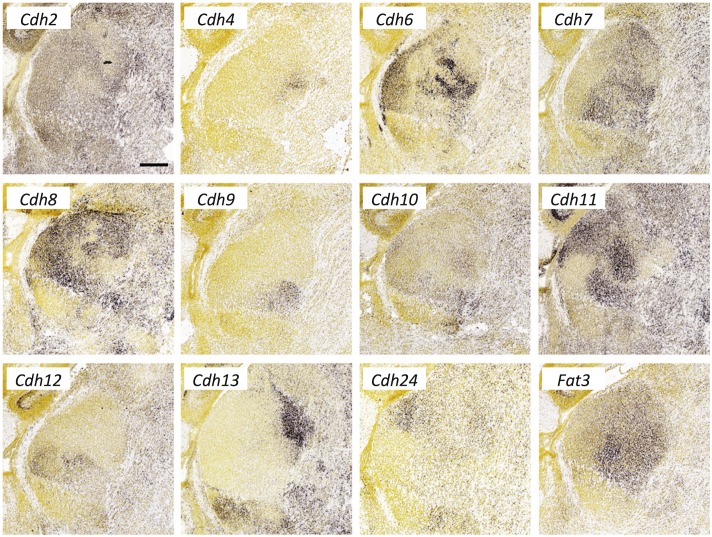
Cadherin expression in the thalamus at E18.5.In situ hybridization data from sagittal sections of the thalamus at E18.5 obtained from the devABA revealed differential patterns of expression of Cadherin (Cdh) 2, 4, 6, 7, 8, 9, 10, 11, 12, 13, 24 and Fat3. See text for details. A representative and equivalent section of medial thalamus is shown for each cadherin (see S8 Fig for details on how the sections were selected). Scale bar in Cdh2: 351 μm.